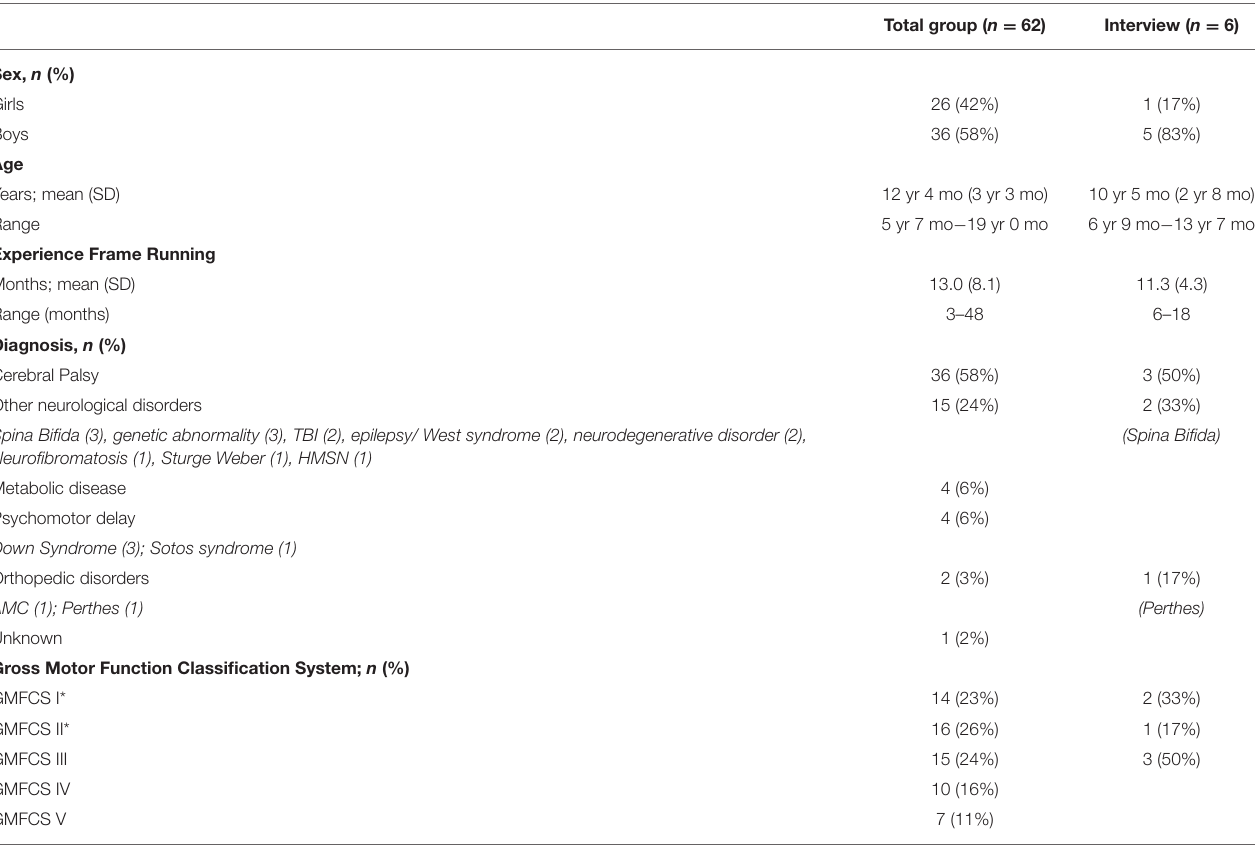
TABLE 1 | Characteristics of the participating Frame Running